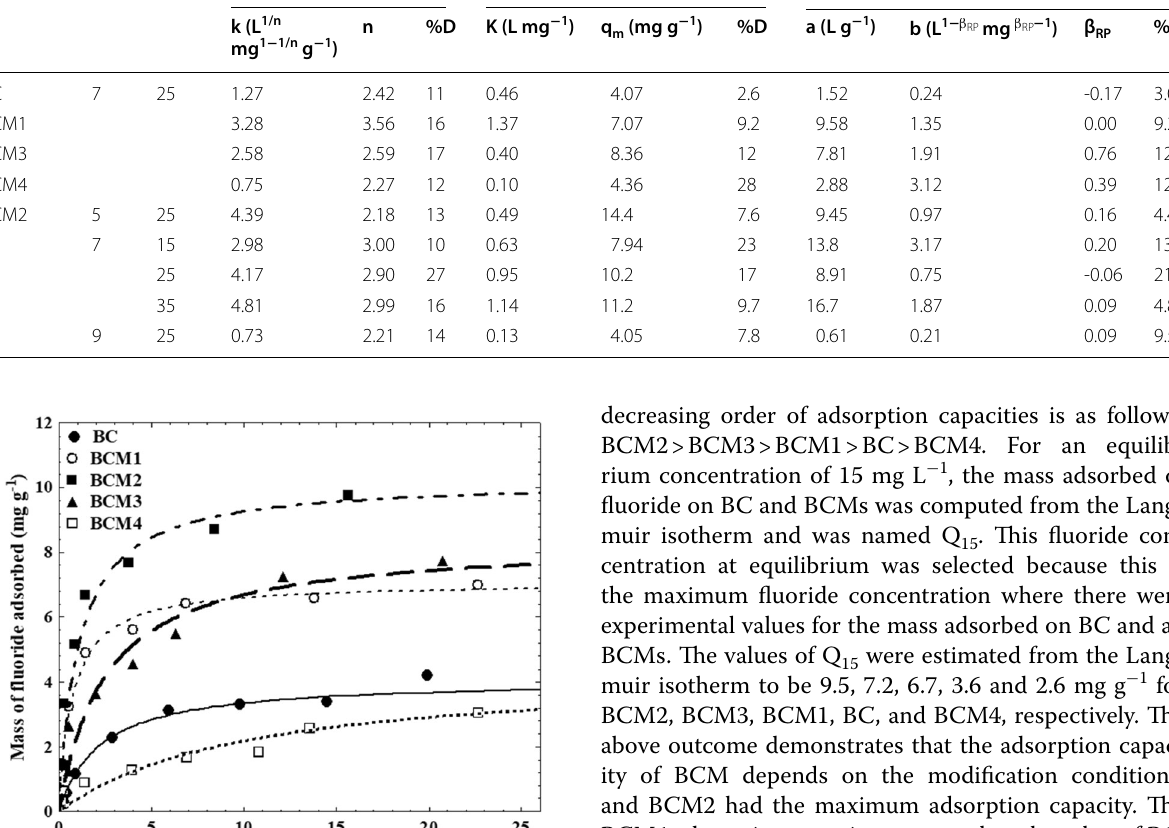
Table 3 Parameters of the Freundlich, Langmuir and Radke‑Prausnitz isotherms for the fluoride adsorption on BC and BCMs from aqueous solution at different pH and temperature Material